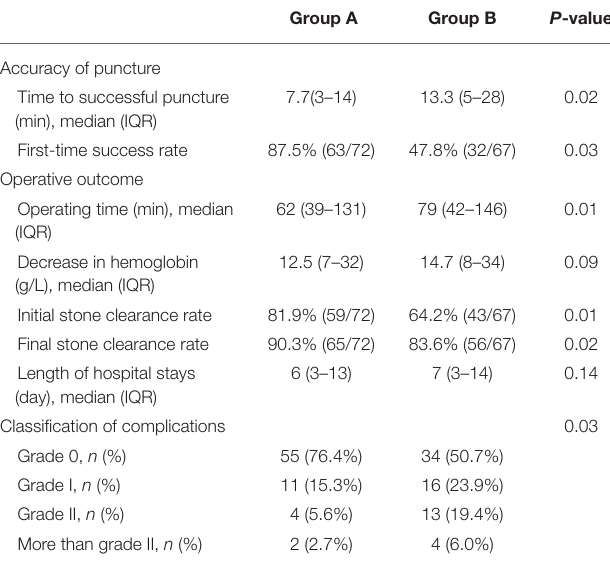
TABLE 2 | The intra- and postoperative clinical